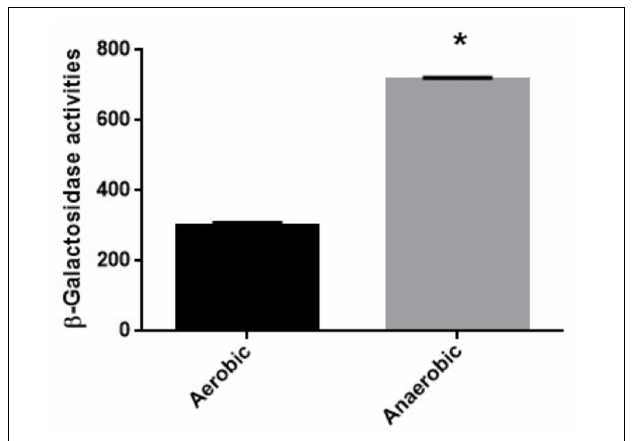
FIGURE 4 | β -Galactosidase activities of Ps.a-682 containing pBBRglpT(Ps.a.-682)-P, the lacZ reporter plasmid grown under aerobic or anaerobic conditions. Data plotted are the means from three independent experiments; error bars indicate the standard deviations, ∗ P < 0.01. Asterisks denote significance for values of glpT promoter activity in Ps.a-682 cultured under anaerobic conditions relative to those under aerobic